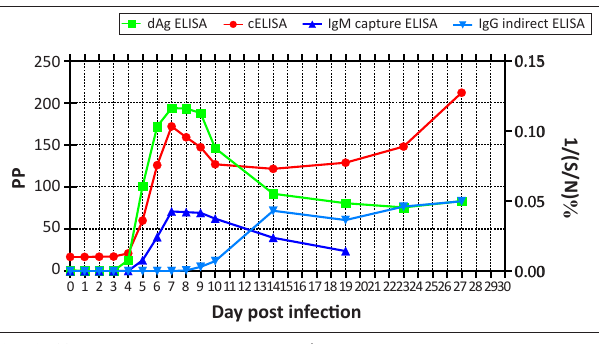
dAg, double-antigen; PP, percentage positive; S/N, suspect or negative. FIGURE 4: Average anti-Rift Valley fever virus nucleoprotein-specific antibody titres in sheep sera collected after infection with virulent Rift Valley fever virus.